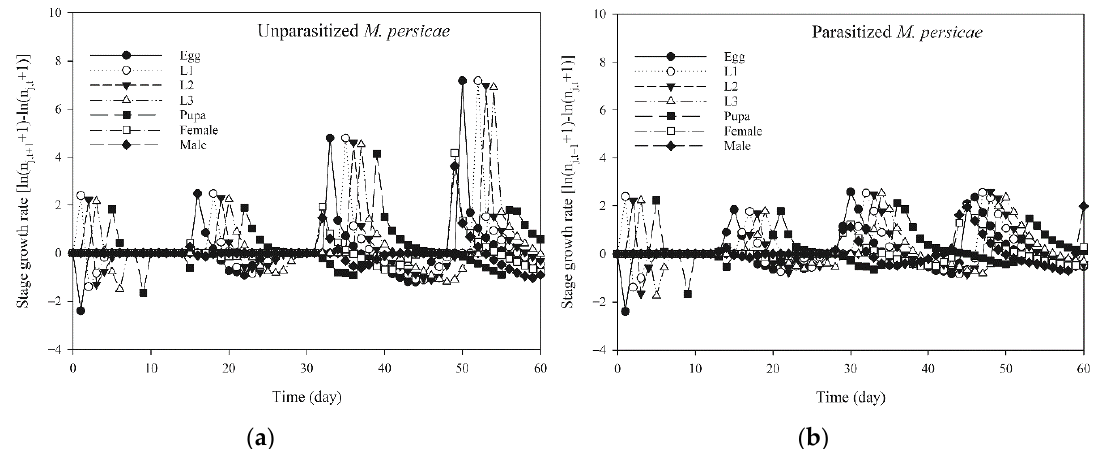
Figure 5. Stage population growth rate of Aphidoletes aphidimyza fed on unparasitized Myzus persicae ( a ) and parasitized Myzus persicae ( b ) by computer simulation.